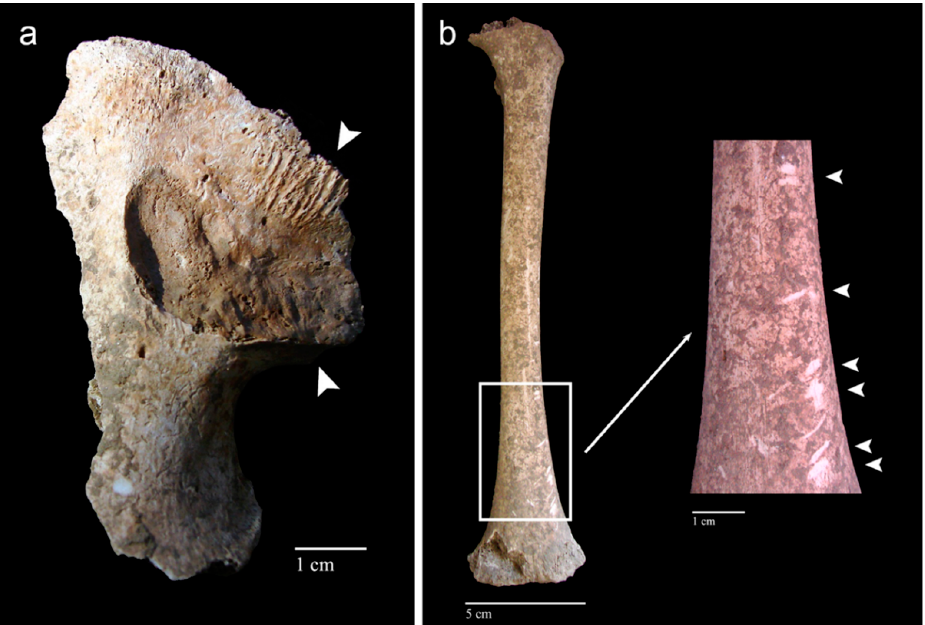
Figure 6. Human skeletal remains from the late medieval cemetery of Corfinio (12th–13th century CE, Italy). ( a ) Fragment of right coxal from a juvenile individual showing signs of rodent gnawing activity near the auricular surface (arrowheads). ( b ) Anterior view of the left femur belonging to a juvenile individual showing scratches that can be confused with signs of tooth marks; however, they are caused by a deficient excavation process using inadequate tools (i.e., lesions of post-mortem origin) (arrowheads). Images courtesy of C. Tanga from her bachelor’s thesis [224].